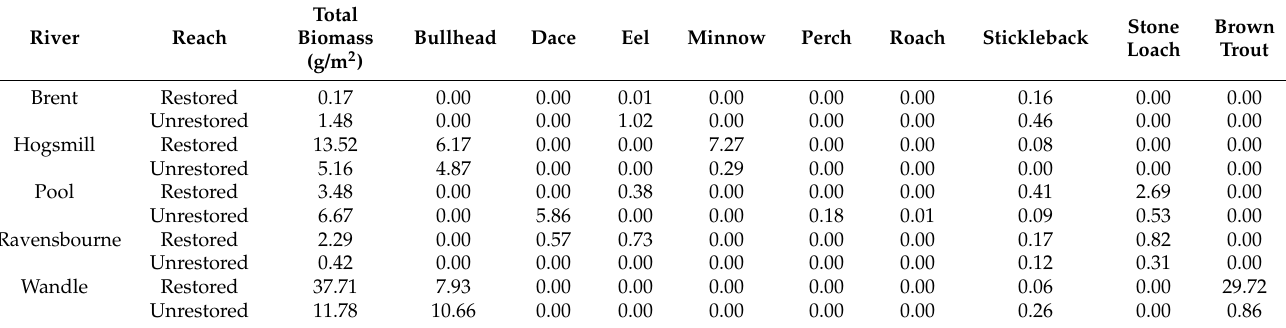
Table 4. The total fish biomass (g/m 2 ) for species across rivers and reaches, comprising all individuals caught across three 25-metre sweeps.